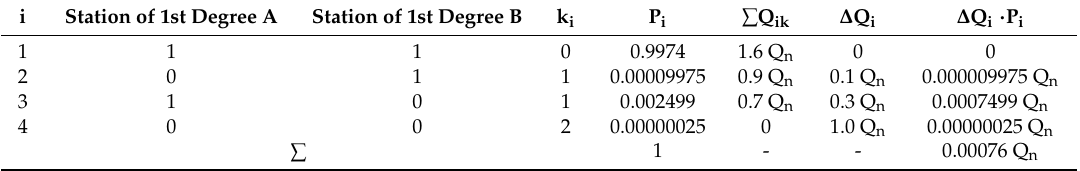
Table 3. Calculation results in individual reliability states on the basis of Tch ó rzewska-Cie´slak